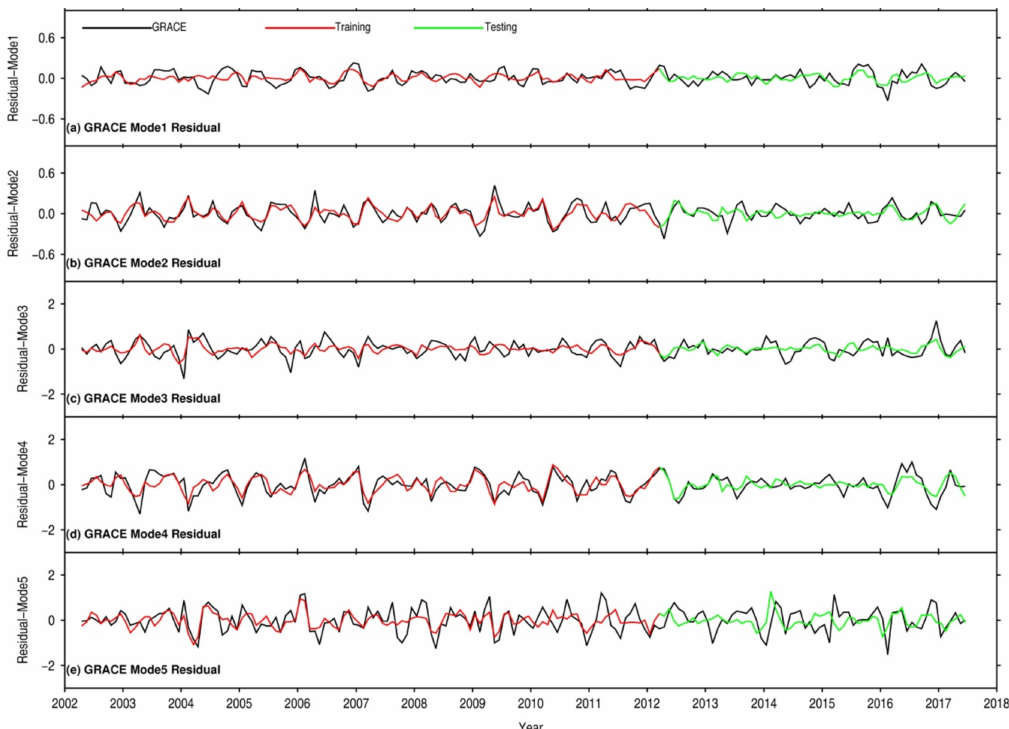
Figure A3. Residual components of the five leading GRACE temporal modes (black lines) relative to the model outputs in the training (red lines) and testing periods (green